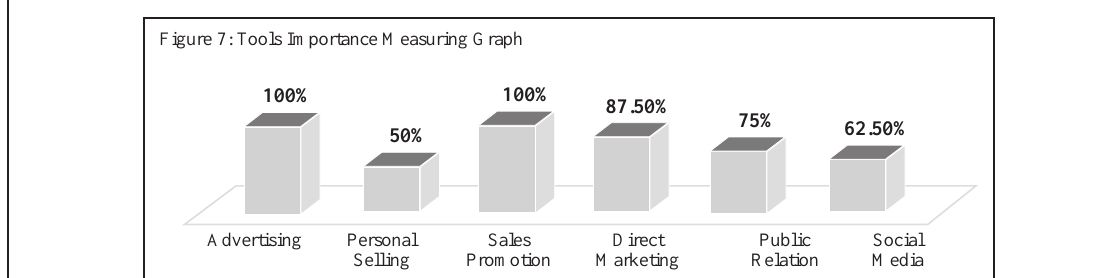
Loyalty & Targeting Specific Retention